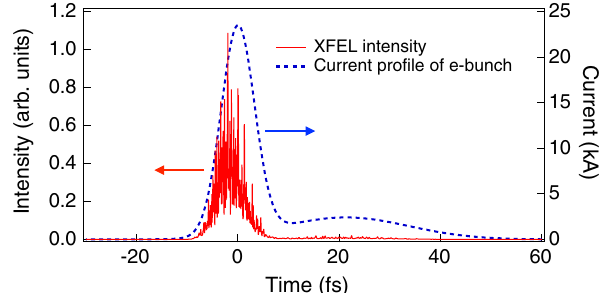
FIG. 4. Simulated temporal structure of the XFEL pulse (red solid curve) and the current profile of the e-bunch determined by the x-ray HBT interferometry (blue dotted